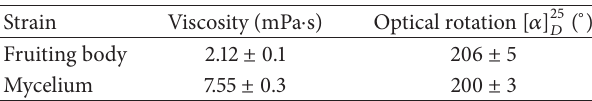
Table 4: The data of viscosity and optical rotation analysis of (1 → 3)- 𝛼 -d-glucans extracted from fruiting body and vegetative mycelium of C. unicolor .